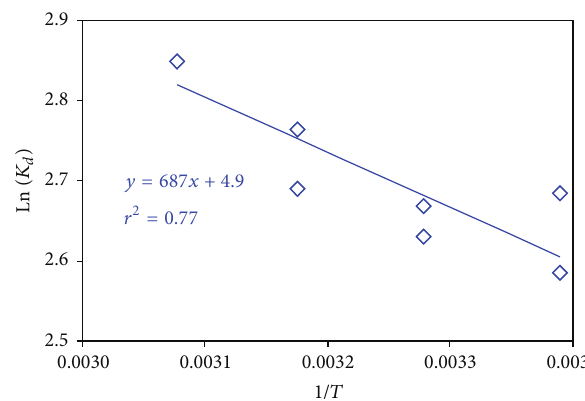
Figure 6: SDZ adsorption on zeolite as affected by equilibrium